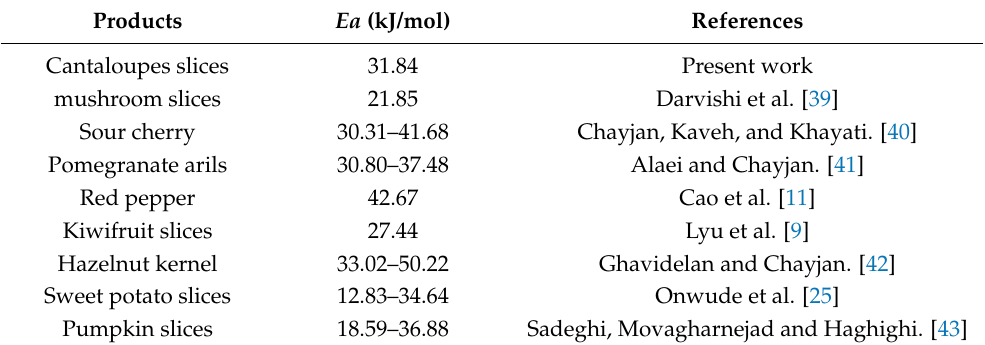
Table 3. Activation energy of cantaloupe slices and other products during IR and IR-assisted drying.